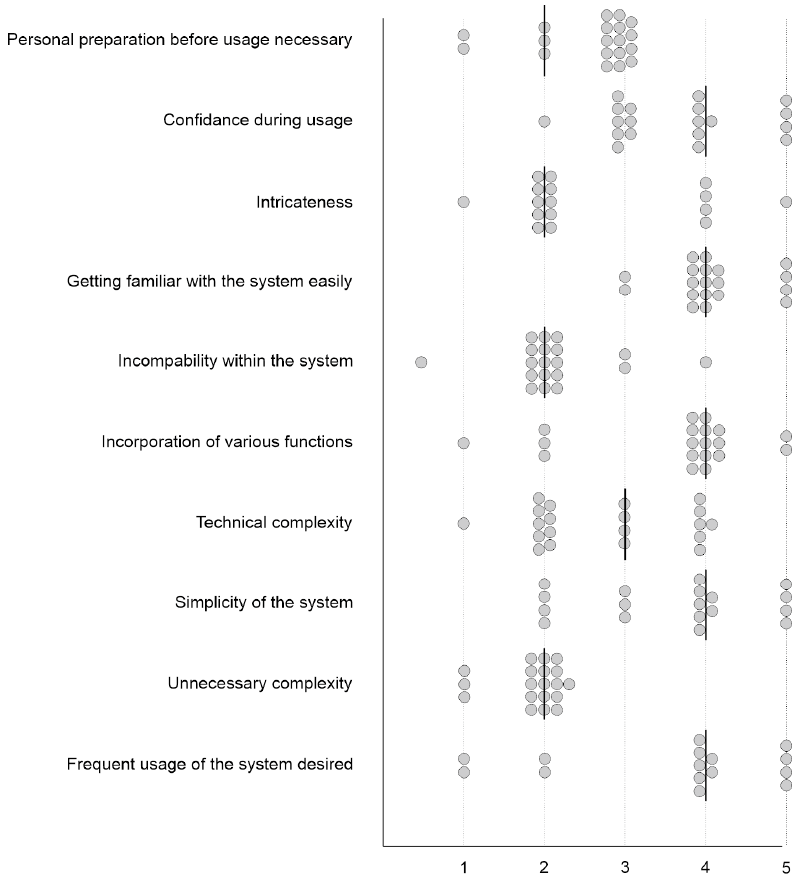
Figure 9. The second questionnaire evaluated the usability of Aeos. The attending surgeon rated the factors listed on the y -axis on a scale from 0, and 5 shown on the x -axis, where 0 is full disagreement, and 5 is full agreement. Dots illustrate ratings and lines illustrate medians.